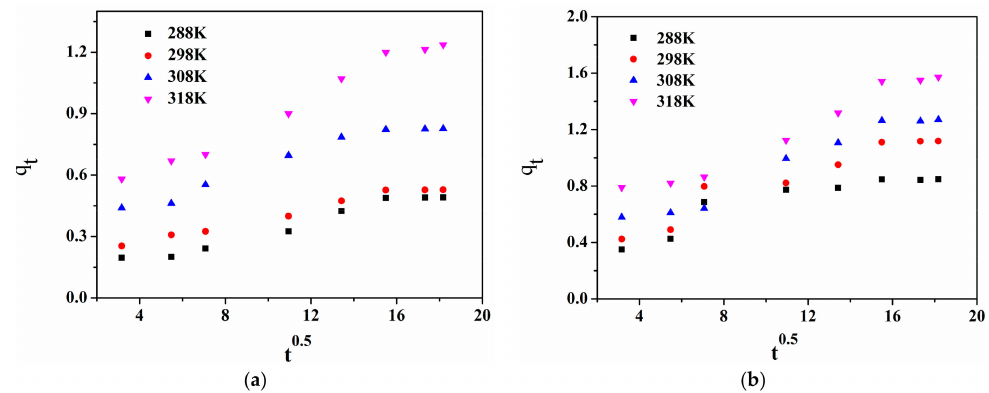
Figure 13. Effect of temperature on 1-naphthol adsorption on raw diatomite. ( a ) And calcined 450 ◦ C diatomite; ( b ) intra-particle diffusion adsorption kinetics